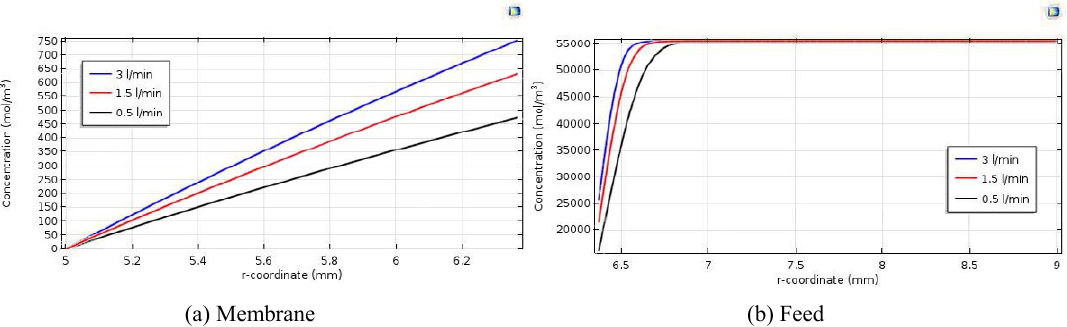
Fig. 10: Water concentration profile vs. r-coordinate at different feed flow rates (60 °C temperature and 1 bar pressure); (a) Membrane section and (b) Feed section